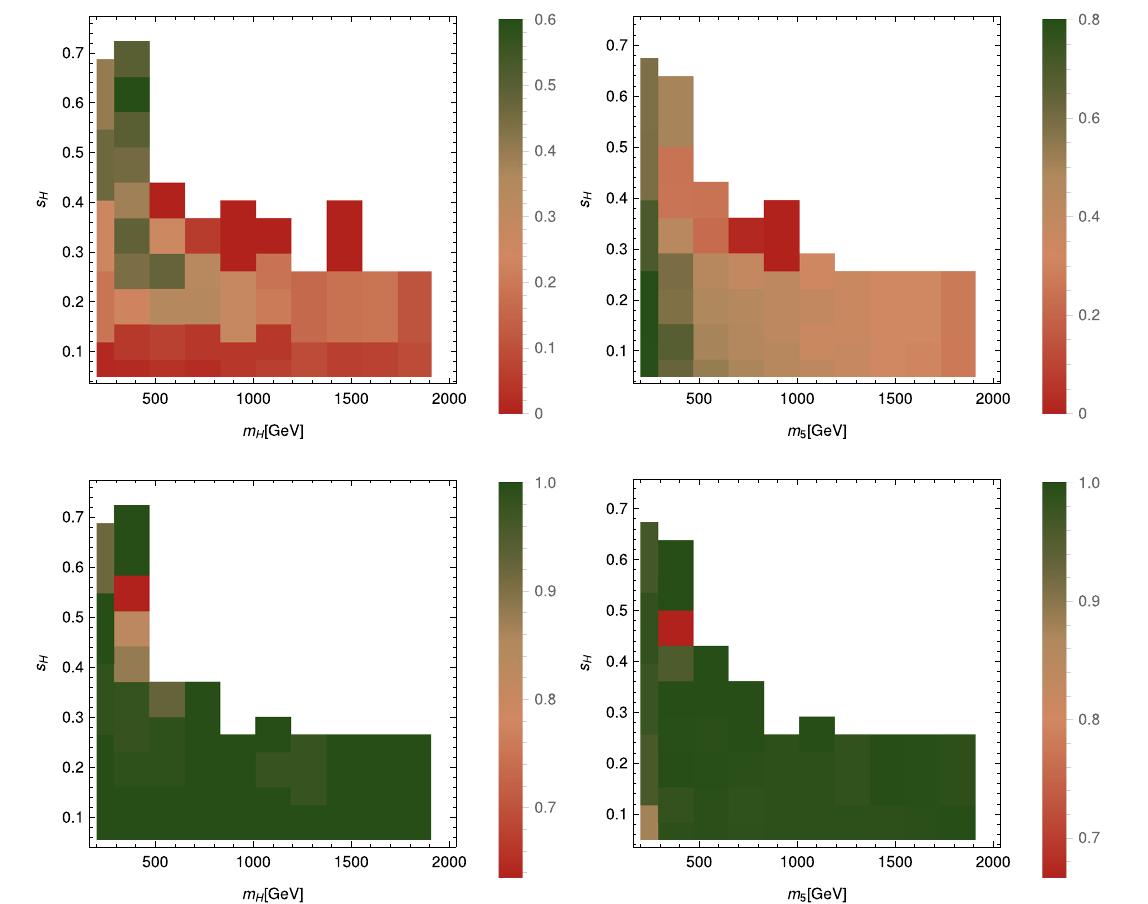
Fig. 18 First row: fraction of those points which are stable at one-loop and also pass the tree-level constraints. Second row: fraction of those points which are stable at tree-level and pass also the loop constraints. The left columns shows the results for Input I, the right column for Input II